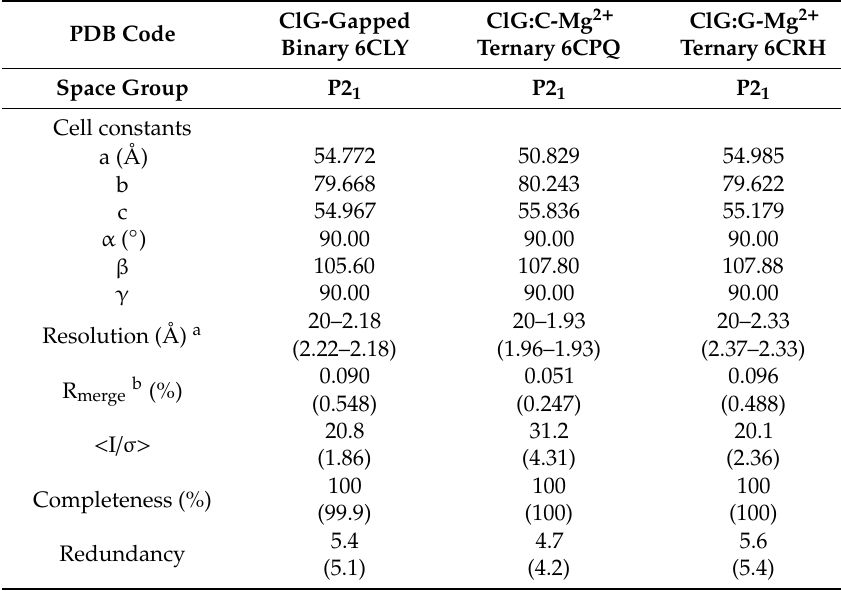
Figure 2. Structure of a single-nucleotide gapped binary complex of pol β and ClG-containing DNA. ( A ) Overall structure of pol β in complex with templating ClG. Templating ClG is shown as colored magenta. The minor groove-interacting α -helix N is colored red. ( B ) Active-site view of the pol β :ClG binary complex. Hydrogen bonds are indicated in dotted lines. Note a water-mediated hydrogen bond network between Tyr271 and ClG and stabilization of syn ClG via a hydrogen bond between N2 of ClG and the 5 ′ phosphate backbone oxygen. Protein is an open conformation. ( C ) DNA sequence used for crystallization of a single-nucleotide gapped pol β complex. The 5 ′ of the downstream primer is phosphorylated. Table 2. Data collection and refinement statistics.